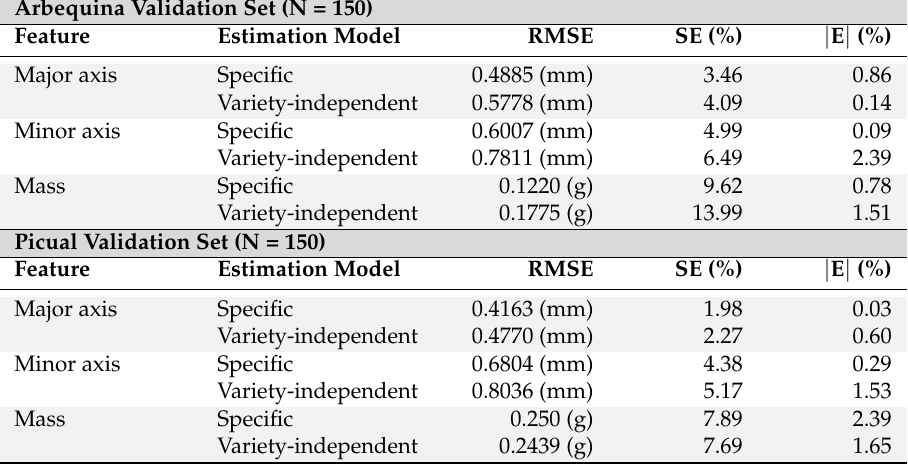
Table 2. Estimation results, calculated on the external validation sets, for the three studied features detailed per variety and modeling approach. Outcomes are expressed in terms of Root-Mean-Square Error (RMSE; Equation (12)), Relative Root-Mean-Square Error (SE; Equation (13)), and Relative Mean Error ( | E | ; Equation